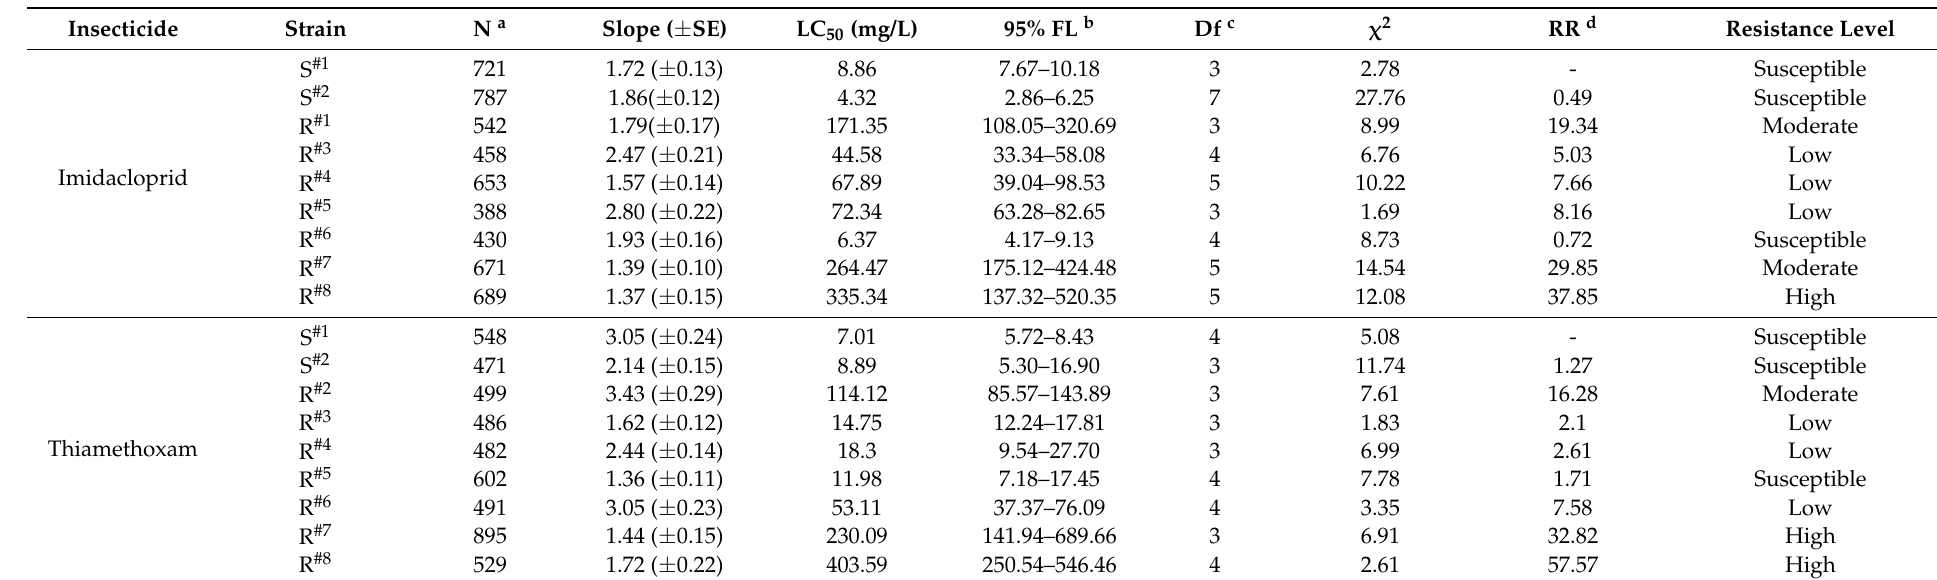
Table 1. Susceptibility of B. tabaci adults to imidacloprid and